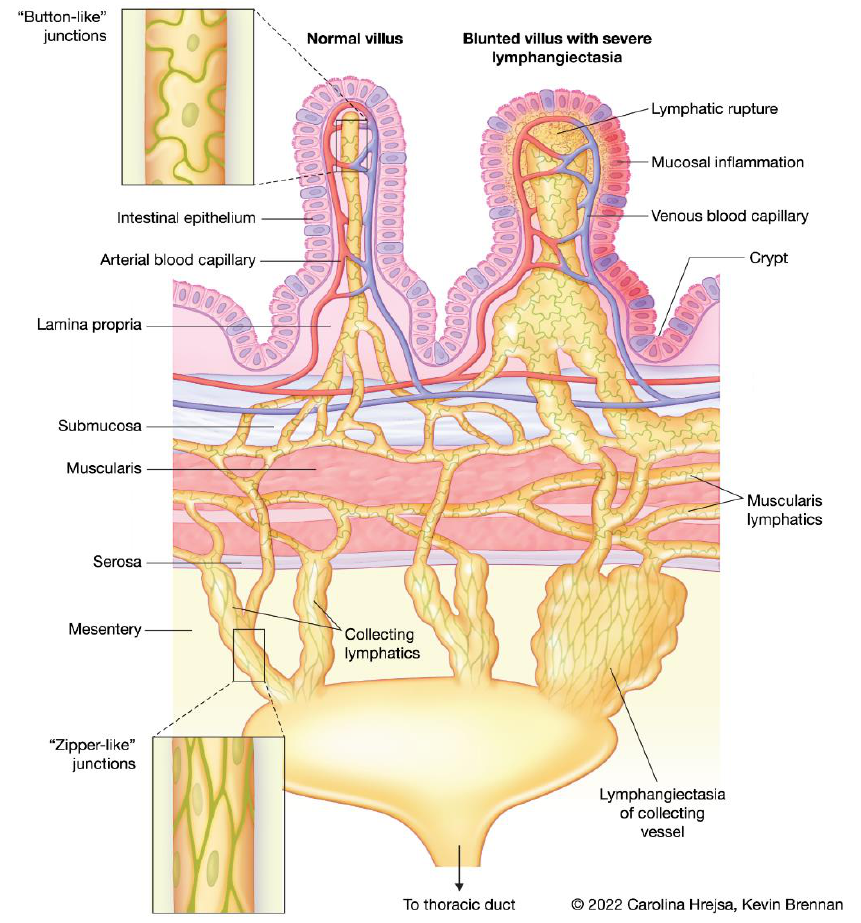
Figure 1. Schematic showing a normal villus with a healthy lacteal, cage-like structure of venous and arterial capillaries, and draining submucosal, muscularis, and collecting lymphatic vasculature. The differences between the cell junctions of the lacteal system versus the collecting lymphatics are depicted (insets). A blunted villus with severe lacteal dilation and lymphatic rupture, and lymphangiectasia of the draining lymphatic vasculature is shown for comparison.